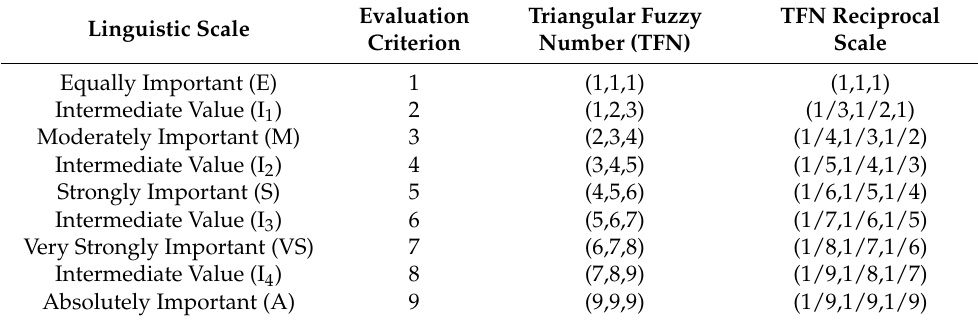
Table 2. Linguistic terms and TFN reciprocal